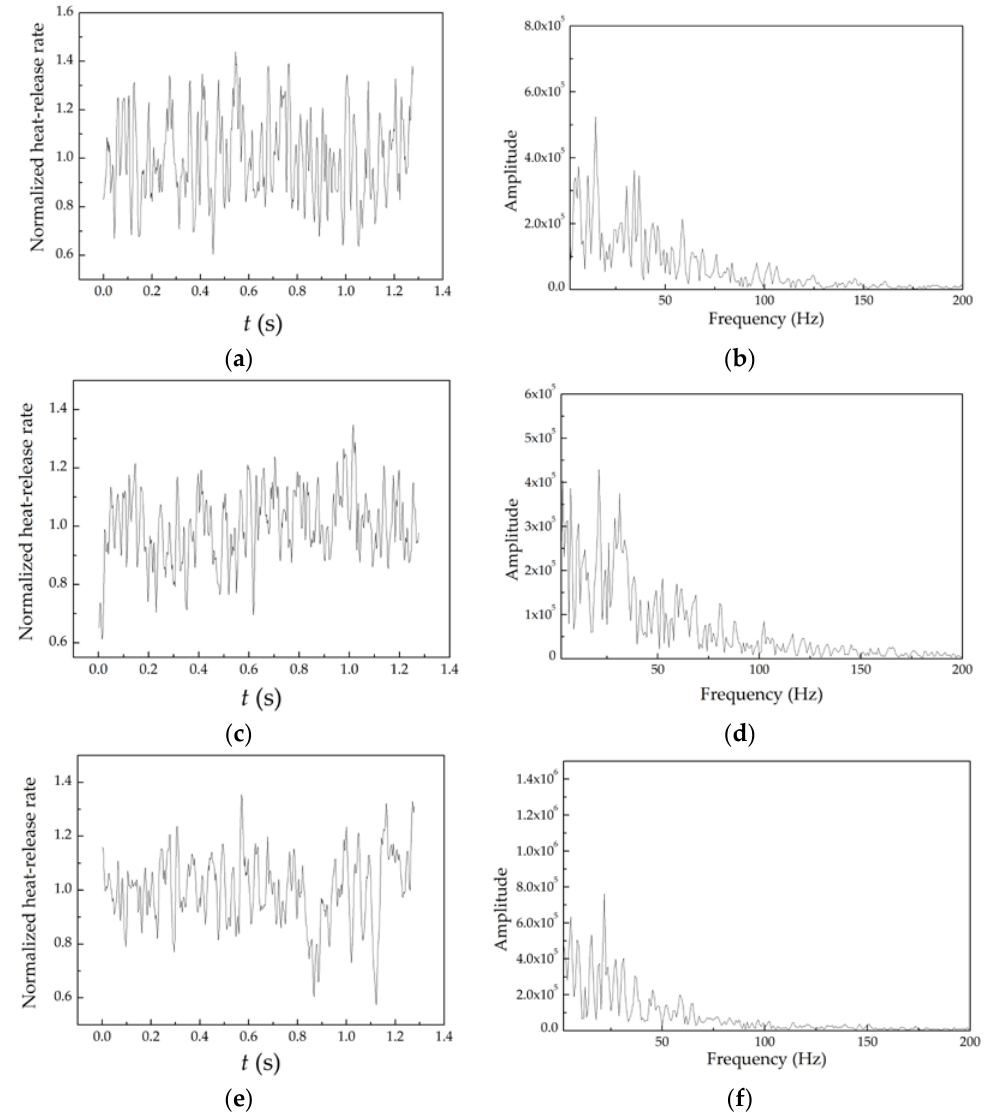
Figure 5. Flame heat-release rate pulsation curves and corresponding spectrum curves for fuel mass flow rate: ( a ) pulsation curve at ṁ F = 12 g/min; ( b ) spectrum curve at ṁ F = 12 g/min; ( c ) pulsation curve at ṁ F = 14 g/min; ( d ) spectrum curve at ṁ F = 14 g/min; ( e ) pulsation curve at ṁ F = 16 g/min; ( f ) spectrum curve at ṁ F = 16 g/min.